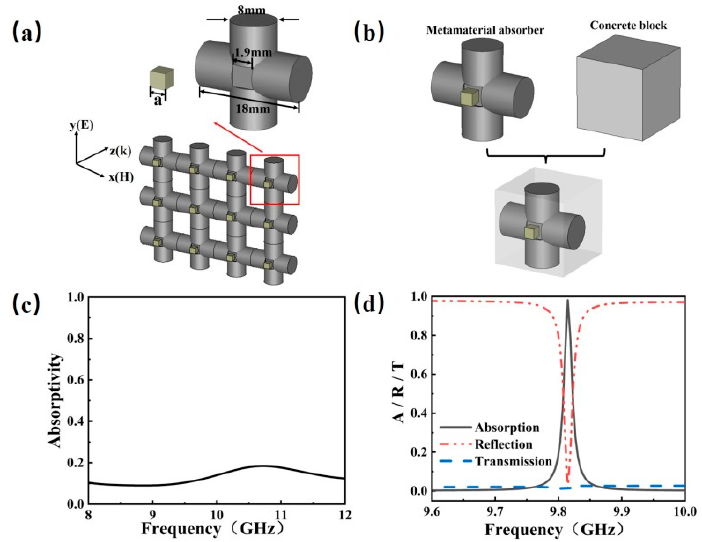
Figure 2. The designed metamaterial absorber and simulation results: ( a ) unit cell of the steel bar structure, in the simulations, the EMW k is incident to the y -axis, with magnetic field H parallel to the z -axis, and electric field E parallel to the x -axis; ( b ) unit cell of the metamaterial absorber within the concrete; ( c ) simulated absorptivity spectrum of concrete without metamaterial absorber; and ( d ) simulated absorptivity spectrum when a = 2.50 mm, ε = 150.